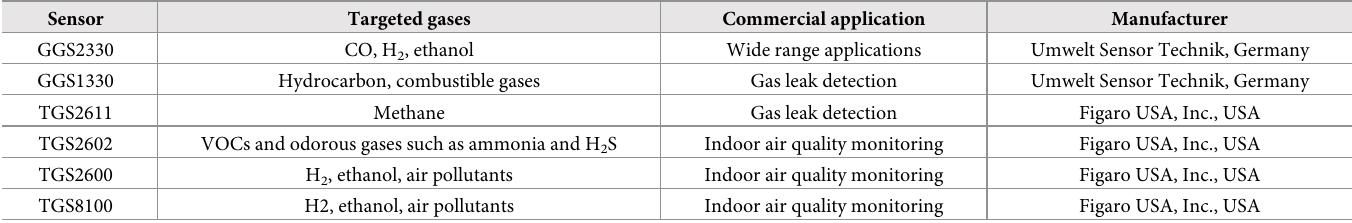
Table 3. MOX sensors for the electronic volatile